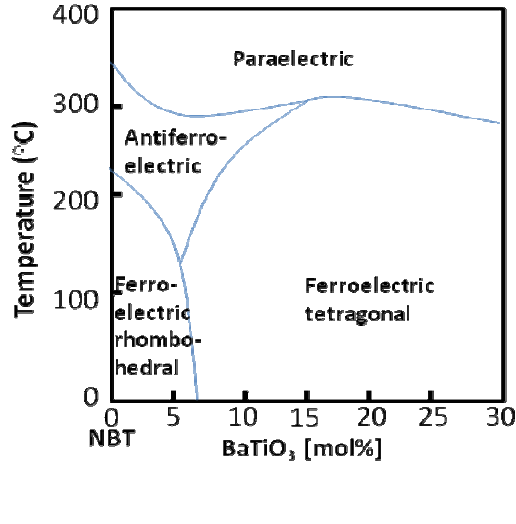
Figure 8. Phase diagram of NBT-BT showing the MPB between the ferroelectric rhomboheral phase and the ferroelectric tetragonal phase, reproduced from Takenaka et al.